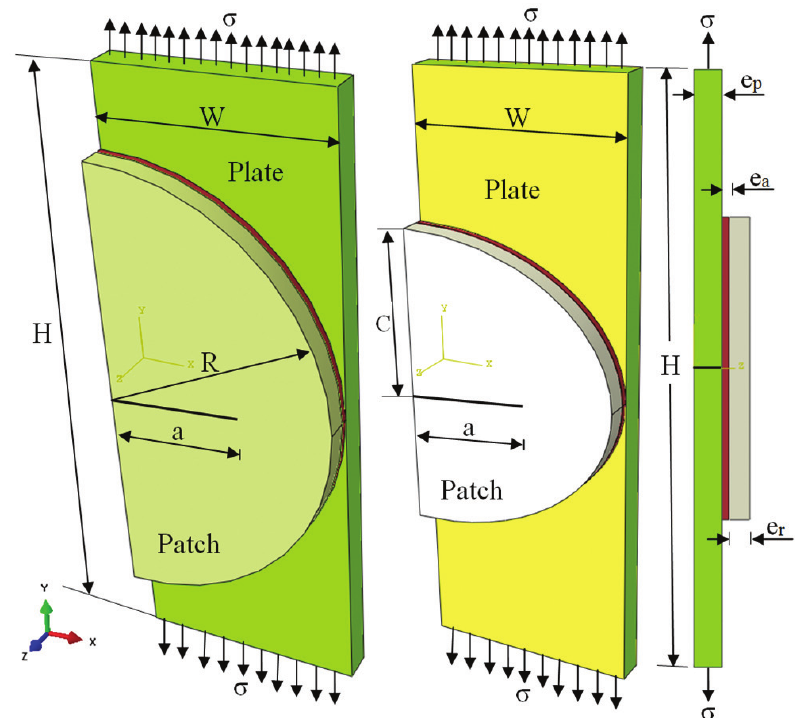
Figure 1. Geometrical